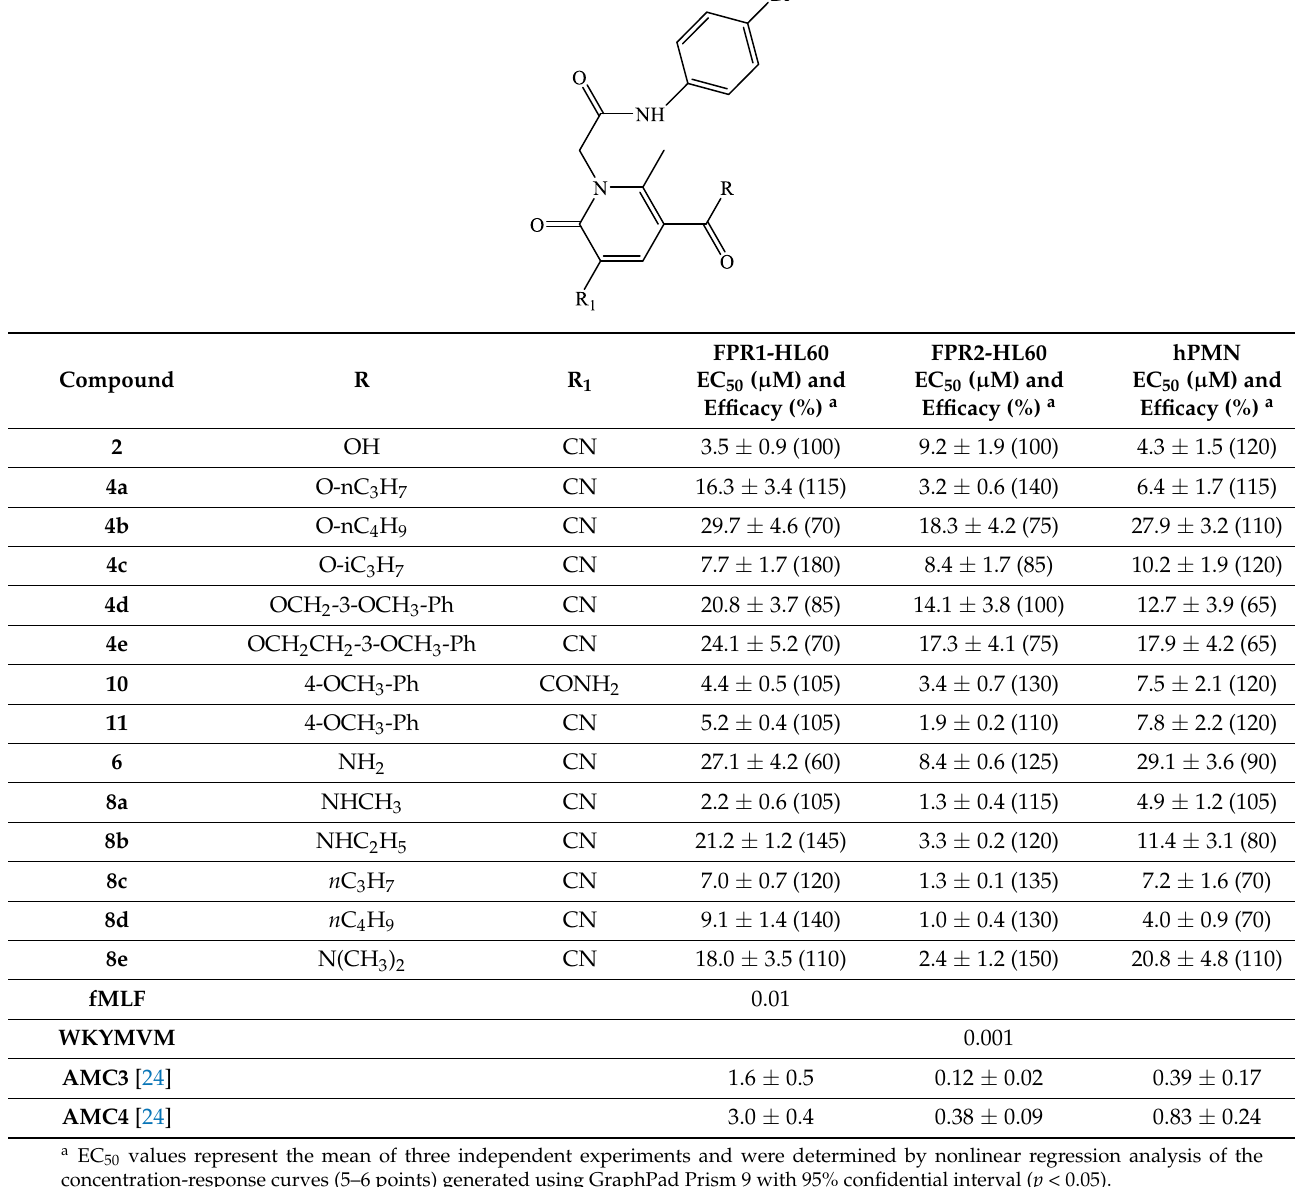
Table 1. Effect of compounds 2 , 4a – e , 6 , 8a – e , 10 , 11 on Ca 2+ mobilization in FPR-transfected HL60 cells.